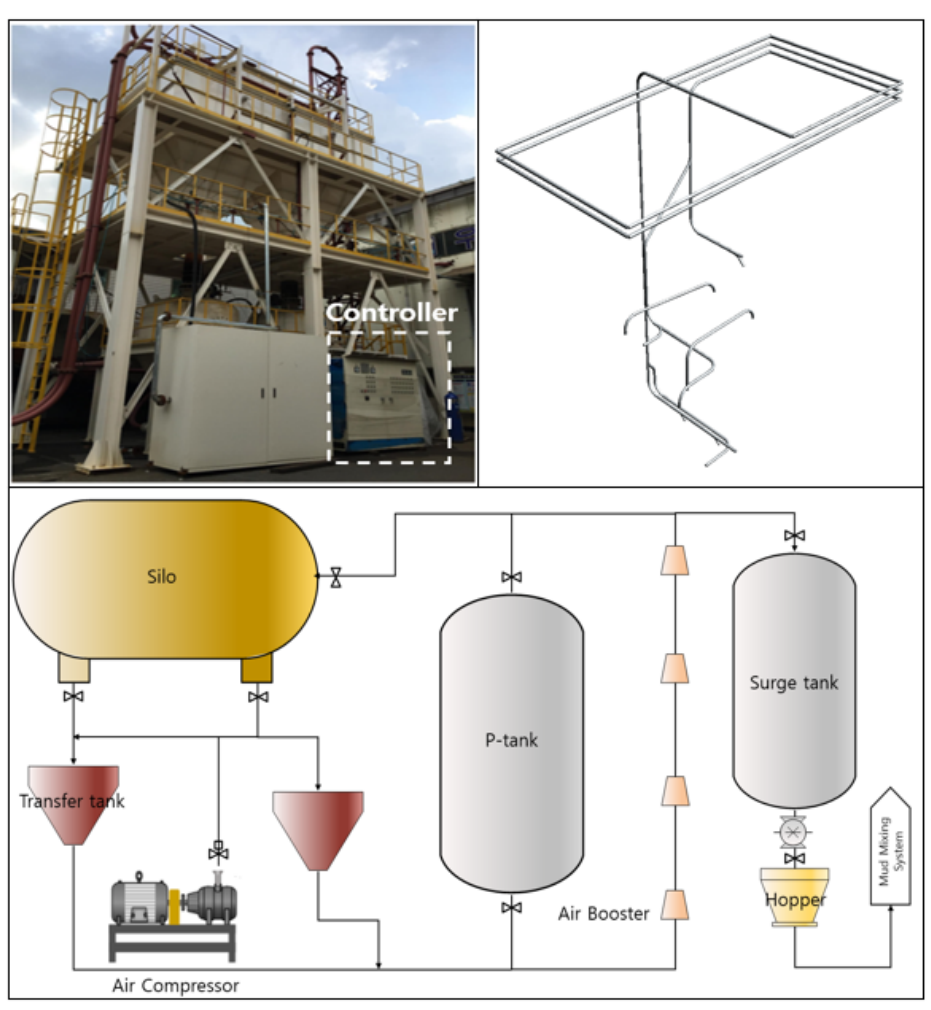
Figure 4. Piping and instrumentation diagram (P&ID) of BTS and three-dimensional pipeline modeling of proposed system.